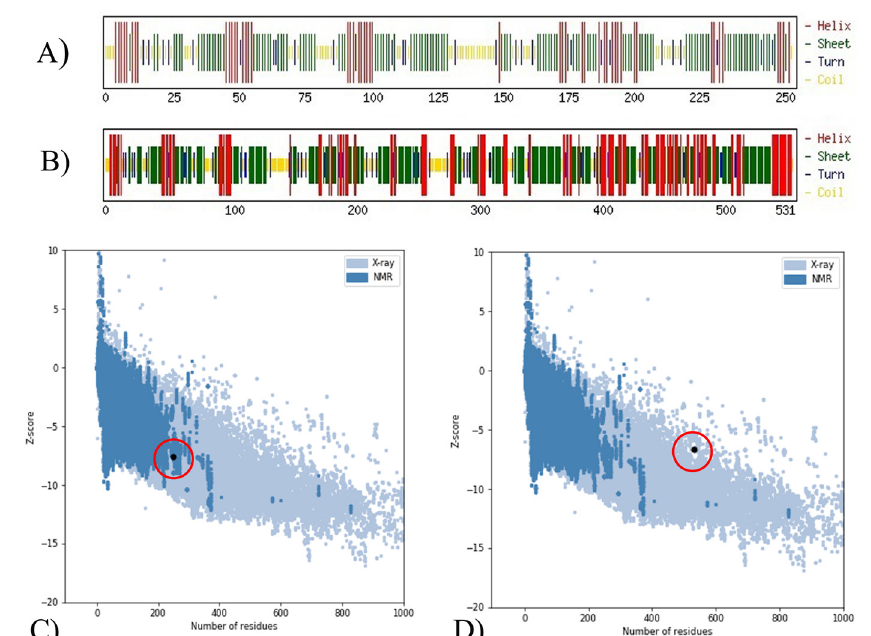
FIGURE 2 - Prediction of the secondary structures and ProSA plots. A and B) Secondary structural analysis of anti-HER2 scFv and the fusion protein, respectively; C and D) ProSA plots of anti-HER2 scFv and the fusion protein, respectively. The black spot in each plot represented the overall quality of the models compared to the experimentally determined protein (X-ray and